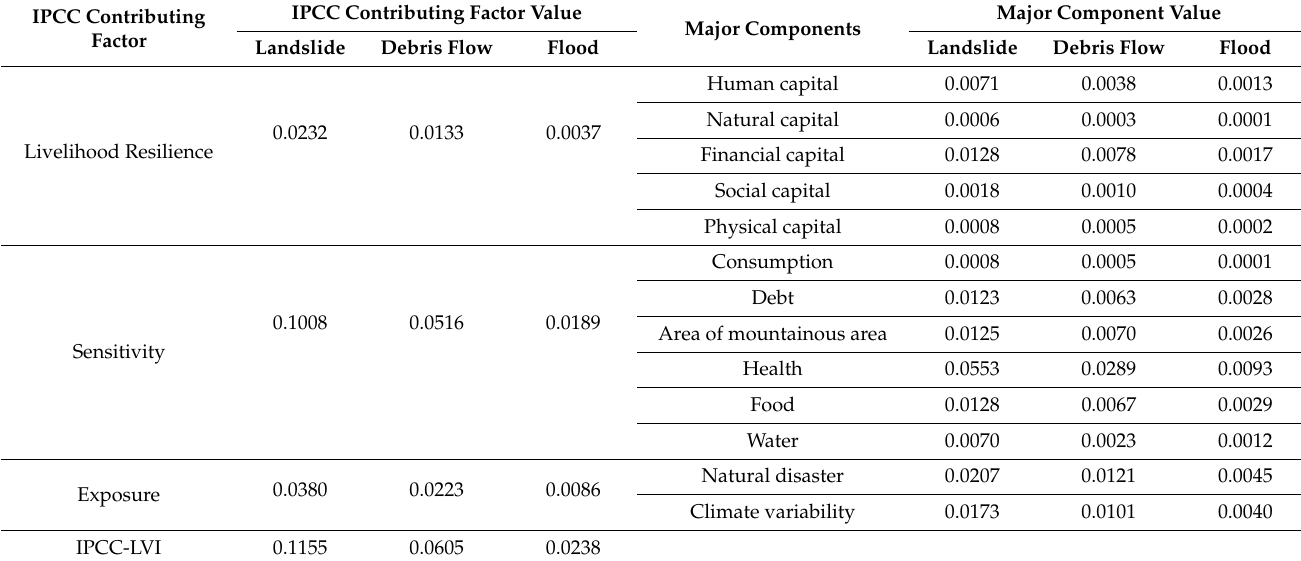
Table 3. Livelihood vulnerability index of different disasters. (Source: the author, 2021). IPCC Contributing